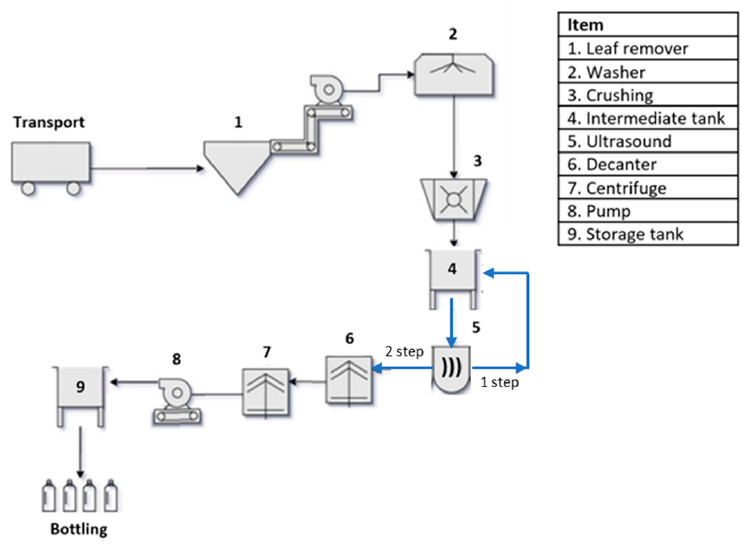
Figure A1. Flow diagram of the 2020 US-assisted pilot-scale